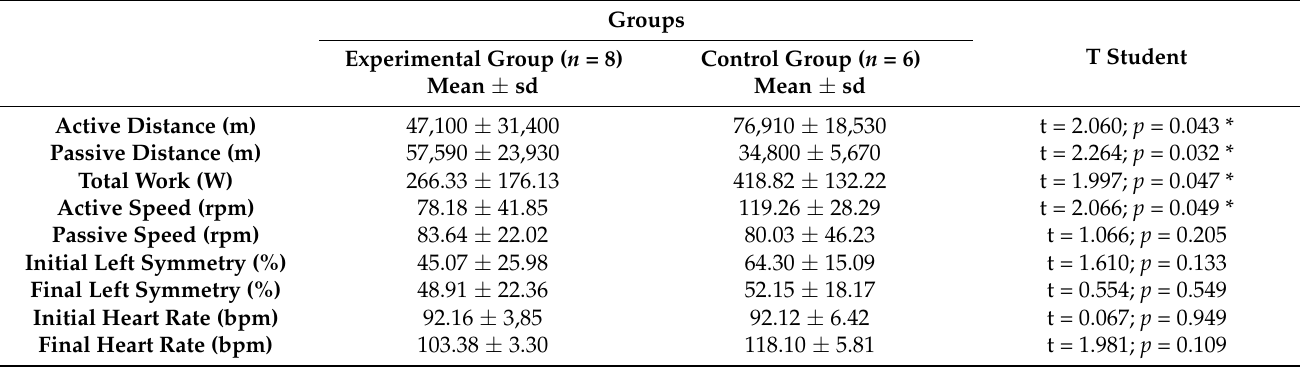
Table 2. Cycling program physical